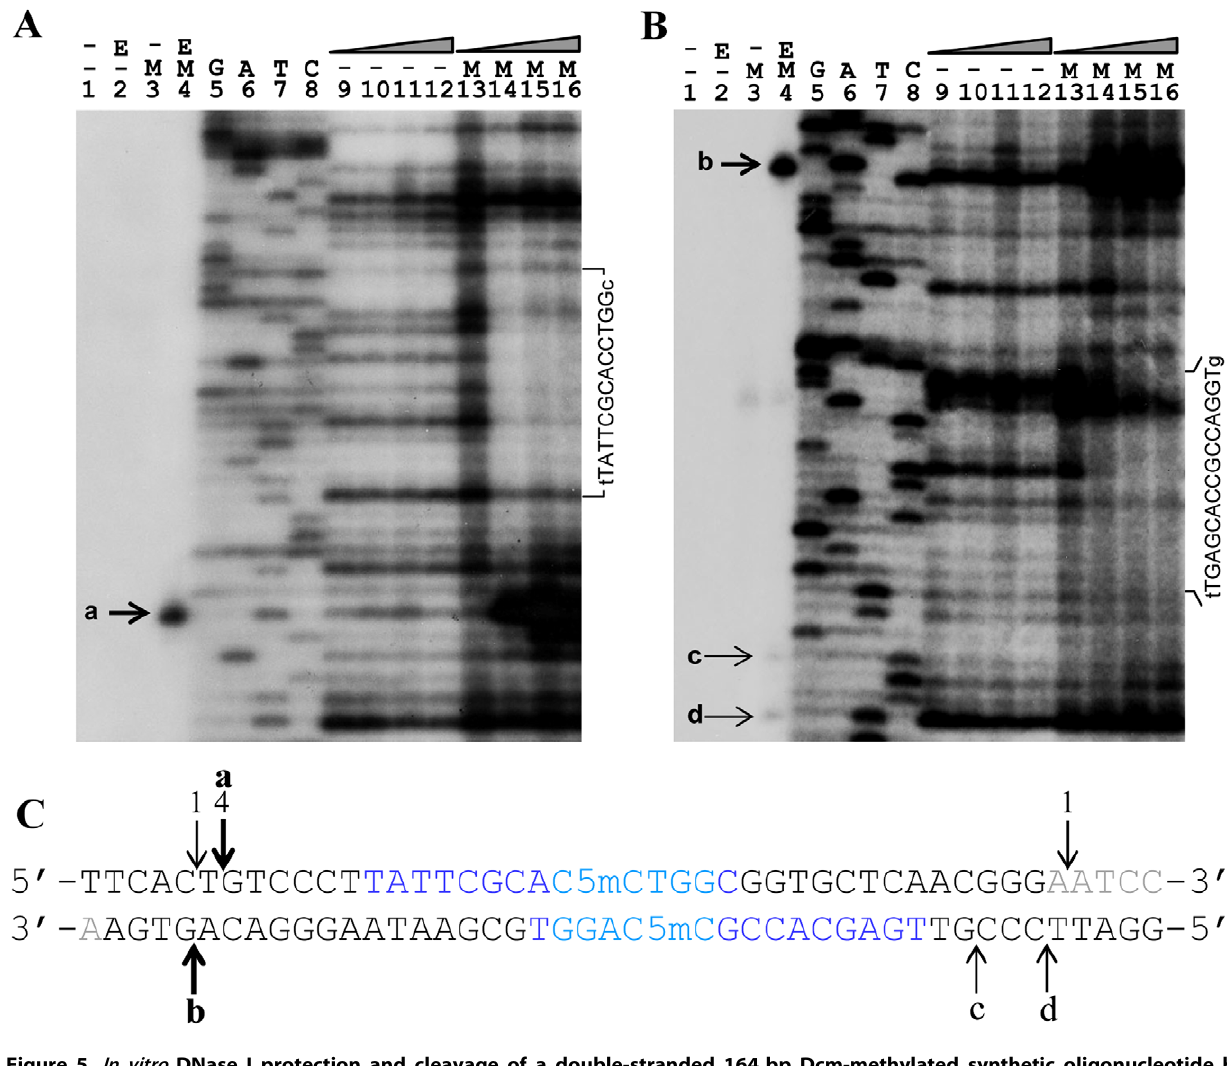
Figure 5. Invitro DNase I protection and cleavage of a double-stranded 164 bp Dcm-methylated synthetic oligonucleotide by purified His 6 -Sco4631. A. Analysis of 5 9 labeled top strand DNA, and B, 5 9 labeled bottom strand DNA. Bands a-d on these autoradiographs represent cleavage of the DNA strands by His 6 -tagged Sco4631. Lanes 1–3 are controls lacking either the enzyme (E) or the Dcm methylation (M). The samples in lanes 4 contained both methylated DNA and active His 6 -Sco4631. Lanes 5–8 are sequencing ladders. Lanes 9–12 are controls containing unmethylated DNA and increasing amounts of active His 6 -Sco4631. Lanes 13–16 contained methylated DNA and increasing amounts of the active His 6 -Sco4631. Lanes 9 and 13 contained no enzyme, and lanes 10–12 and lanes 14–16 contained 1.1, 4.5 and 18 m M enzyme, respectively. The vertical sequence to the right of each gel picture indicates the DNA regions that were partially protected from cleavage by DNase I. The horizontal lines point to bases that are not protected and shown in lower case letters. (Please note, panel A shows the correct sequence of the top strand, but in panel B there is a compression of the sequence with the bold bases in the sequence CCAGGTGCGAATAAG not visible.) C. Central sequence of the 164 bp double-stranded oligonucleotide containing the Dcm methylated sequence C5mCWGG (dark blue) and additional sequences protected against DNase I activity (light blue). The fat vertical arrows labeled a and b are the major cut sites, and the thin arrows labeled c and d are minor cut sites indicated in the gels A and B. Arrows with numbers indicate cut sites that were identified by cloning and sequencing (see Figure 3). Bases printed light grey are not visible on the gel sections